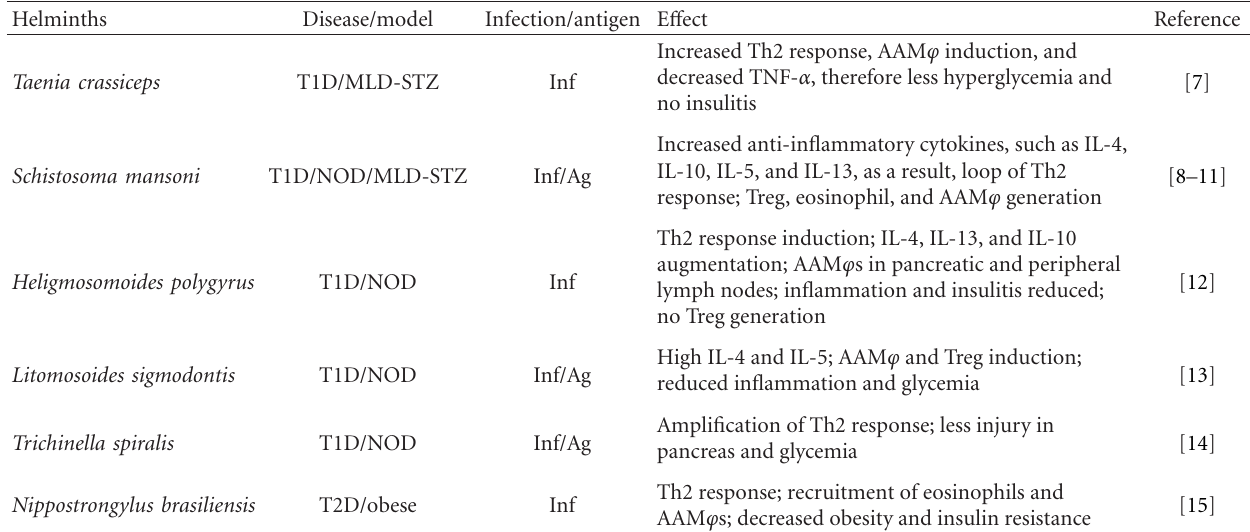
Table 1: Helminths that reduce types 1 and 2